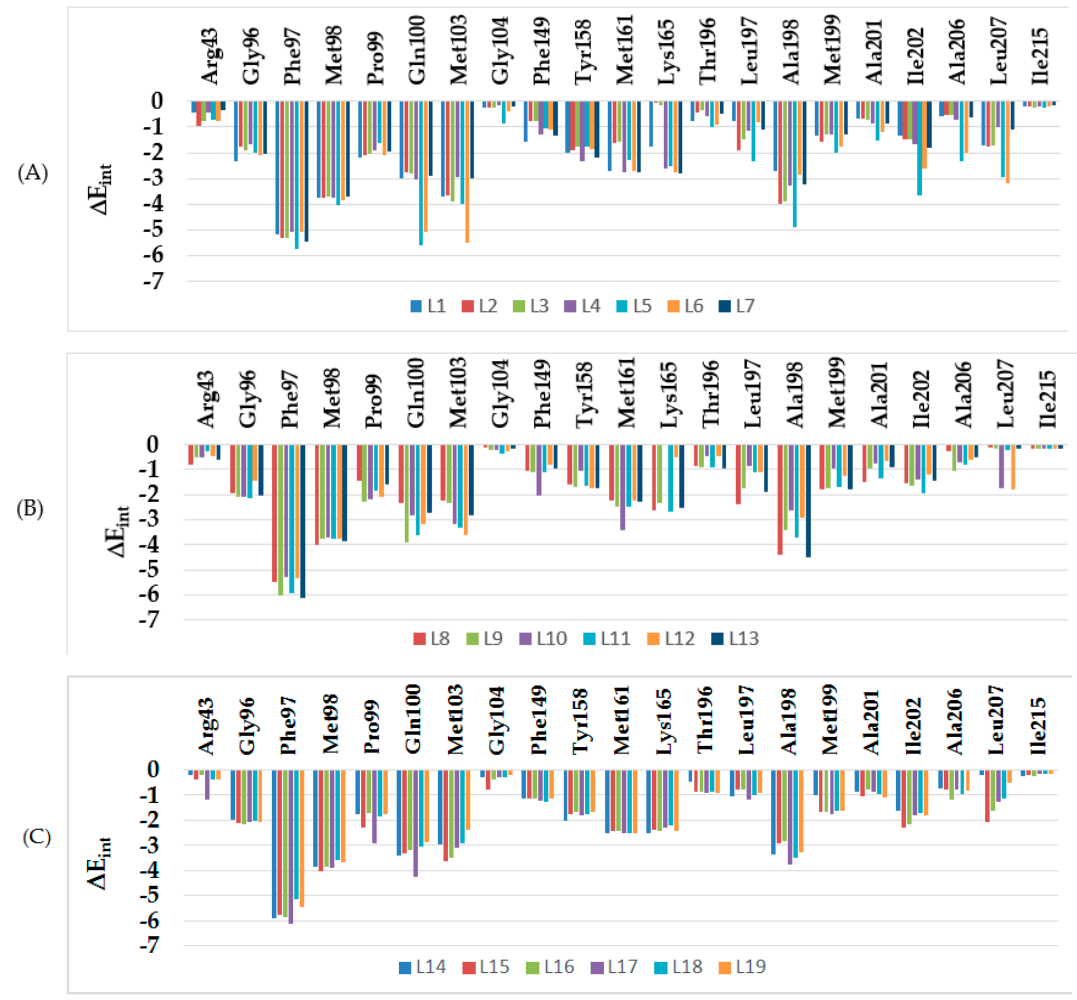
Figure 4. Mechanics intermolecular interaction energy E int breakdown to residue contributions in